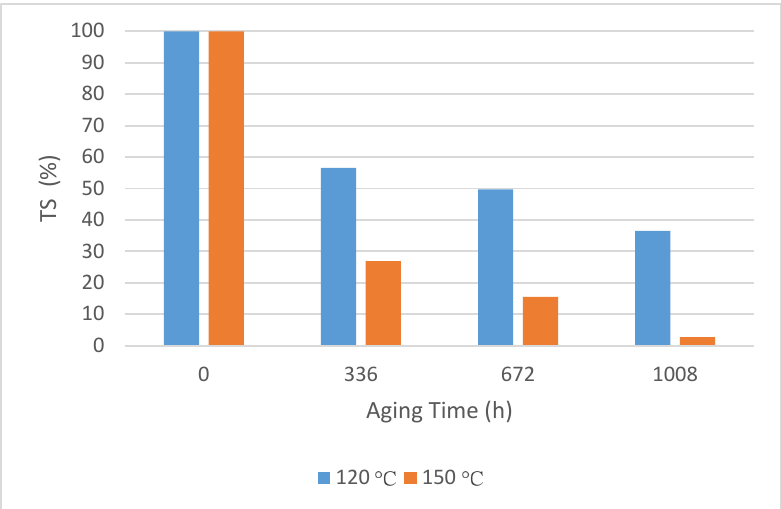
Figure 3. Measured TS of paper samples.